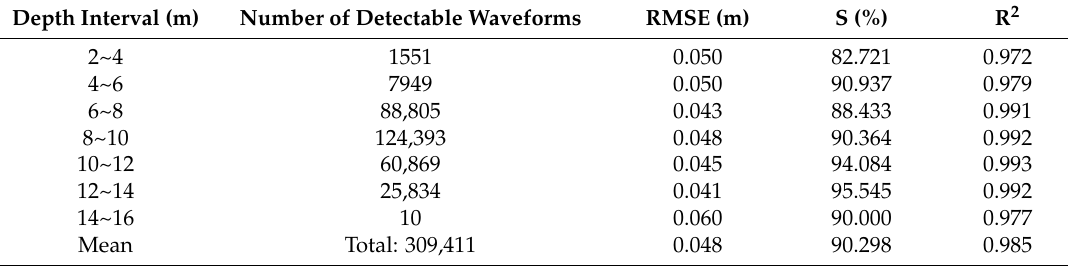
Table 8. Performance of the GHPD method in Experimental area